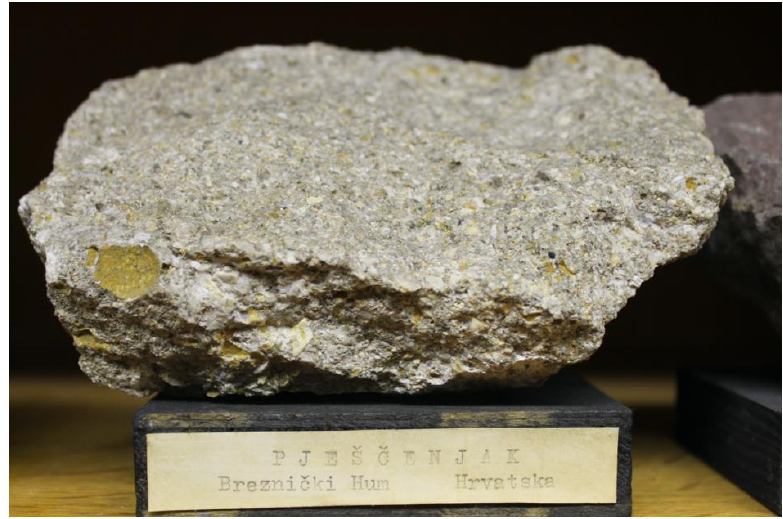
Figure 4. A sample of typical Middle Miocene (Badenian) calcarenite from northern Croatia (Breznički Hum locality). Collection of the Faculty of Mining, Geology and Petroleum Engineering.